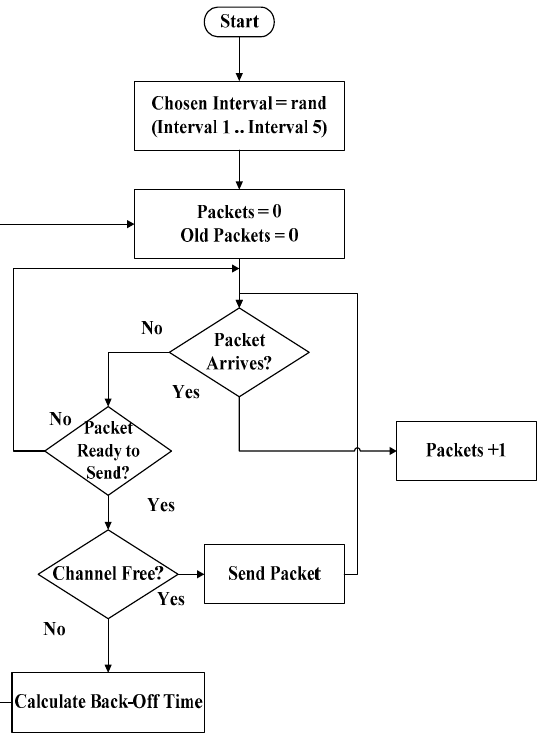
Figure 2. Back-Off Time Optimization based on the Simulated Annealing Algorithm.